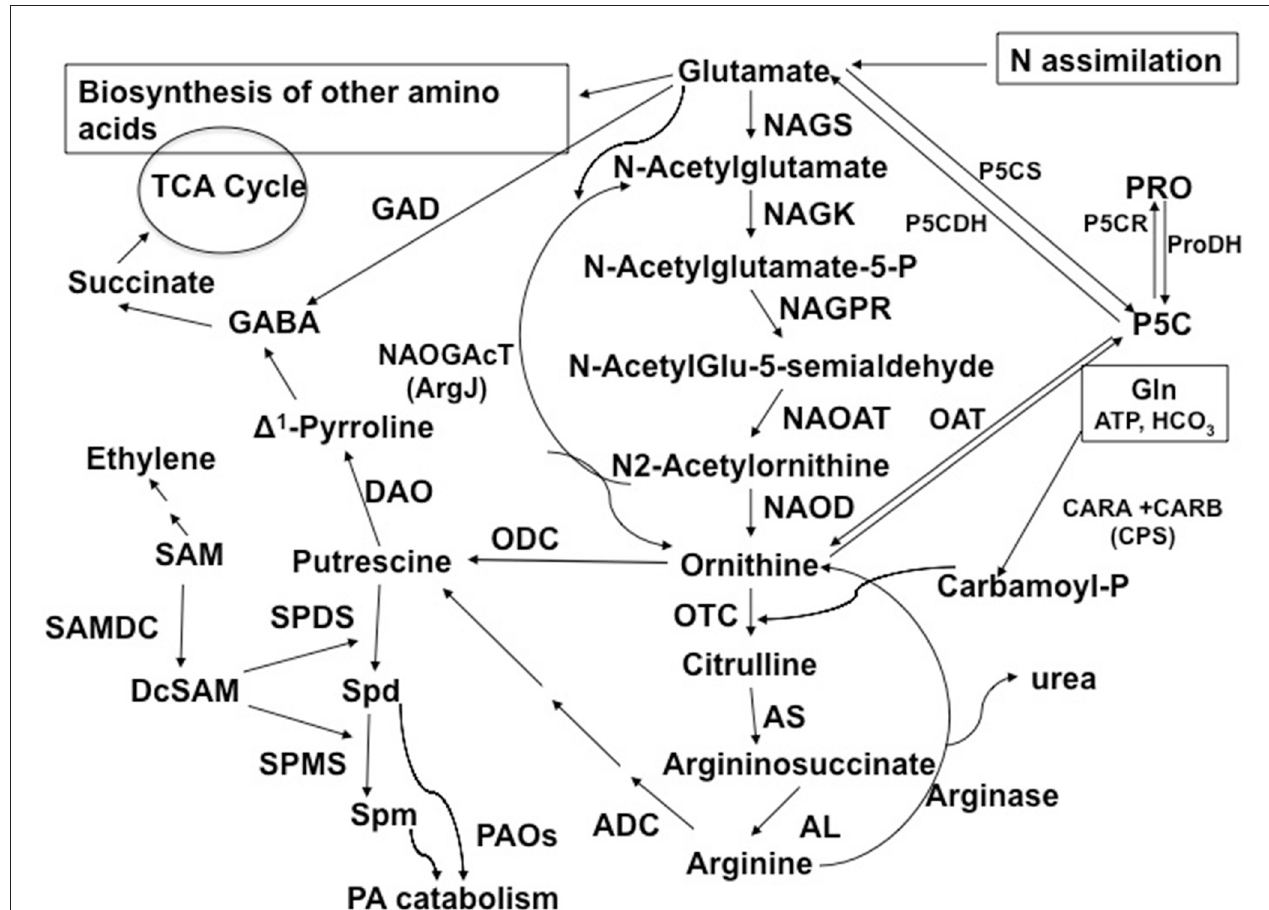
FIGURE 1 | Abbreviated pathway for the biosynthesis and metabolism of Orn in plants in connection to polyamines, amino acids, TCA cycle metabolites, and alkaloids. Abbreviations and EC numbers of the enzymes: ADC, arginine decarboxylase (EC 4.1.1.19); AL, argininosuccinate lyase (EC 4.3.2.1); AS, argininosuccinate synthase (EC 6.3.4.5); CPS (CARA and CARB, carbamoylphosphate synthetase (EC 6.3.5.5); DAO, diamine oxidase (EC 1.4.3.22); GAD, glutamate decarboxylase (EC 4.1.1.15); NAGK, N -acetylglutamate kinase (EC 2.7.2.8); NAGPR, N -acetylglutamate-5-phosphate reductase (EC 1.2.1.38); NAGS, N -acetylglutamate synthase (EC 2.3.1.1); NAOAT, N-acetylornithine aminotransferase (EC 2.6.1.11); NAOD, N-acetylornithine deacetylase (EC 3.5.1.16); NAOGAcT, N 2 -Acetylornithine:Glu-acetyl transferase or ArgJ (EC 2.3.1.35); OAT, ornithine δ -aminotransferase (EC 2.6.1.13) ; ODC, ornithine decarboxylase (EC 4.1.1.17) ; OTC, ornithine transcarbamoylase (EC 2.1.3.3) ; ProDH, proline dehydrogenase (EC 1.5.99.8) ; P5CDH, 1 1 -pyrroline-5-carboxylate dehydrogenase (EC 1.5.1.12); P5CR, 1 1 -pyrroline-5-carboxylate reductase (EC 1.5.1.2); P5CS, 1 1 -pyrroline-5-carboxylate synthetase (EC 2.7.2.11/1.2.1.41); SAMDC, S -adenosylmethionine decarboxylase (EC 4.1.1.50); SPDS, spermidine synthase (EC 2.5.1.16); PAO, polyamine oxidase (EC 1.5.3.11); SPMS, spermine synthase (EC 2.5.1.22). Modified from Majumdar et al.